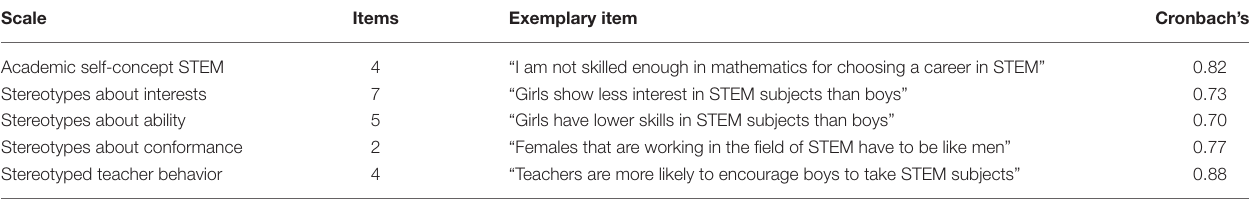
TABLE 1 | Overview on the scales used for the study with the number of items, an exemplary item, and the internal consistency.